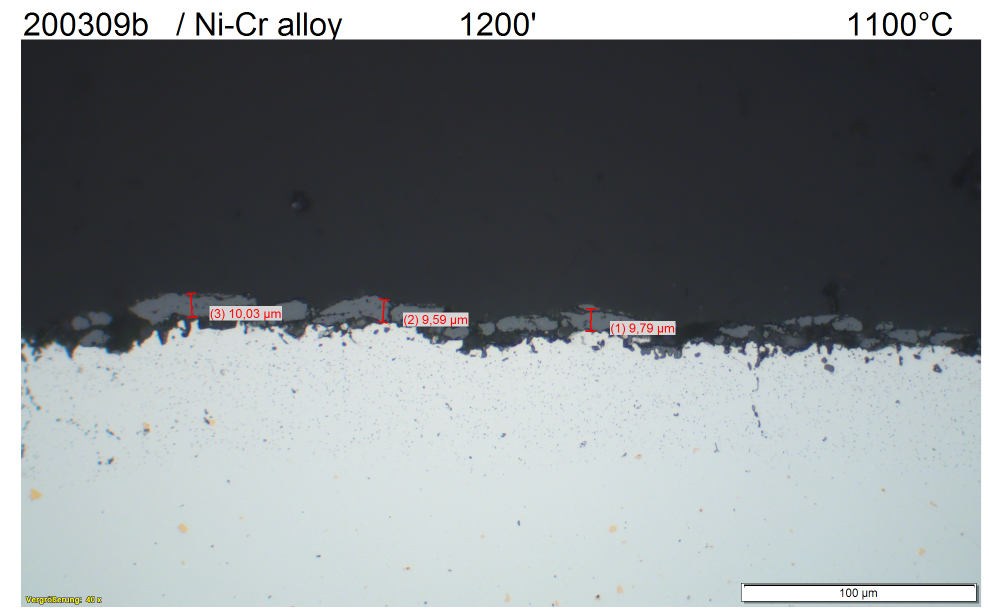
Figure 8. Microstructure of specimen cross sections after isothermal oxidation at 1100 °C in steam for 20 hours